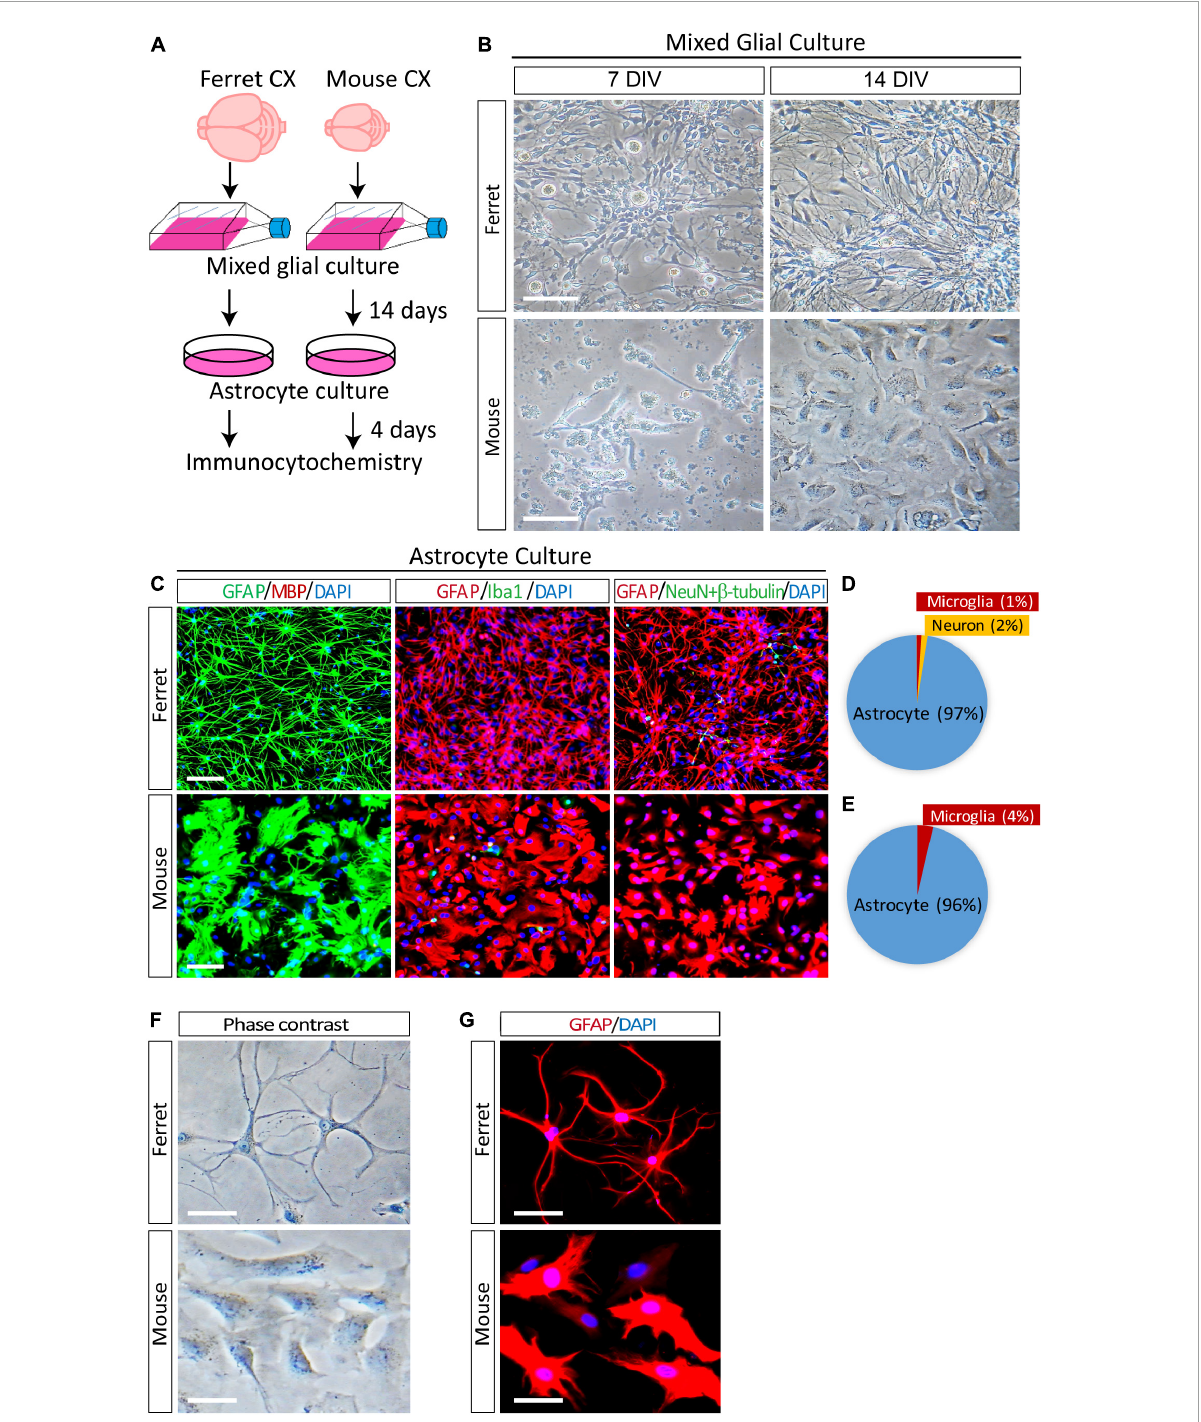
FIGURE1 Purification and morphological analysis of ferret and mouse astrocytes. (A) Experimental procedure used to culture ferret and mouse astrocytes. Mixed glial cells and astrocytes were cultured in media containing 10% fetal bovine serum. (B) Representative phase-contrast images of ferret and mouse mixed glial culture at 7 and 14 days in vitro (DIV). Scale bars = 100 µ m. (C) Cultured ferret and mouse astrocytes were subjected to immunocytochemistry of GFAP, MBP, Iba1, NeuN, and β -III tubulin at 4 days after plating. Nuclei were counterstained with DAPI. Scale bars = 100 µ m. (D,E) Proportion of astrocytes, oligodendrocytes, microglia, and neurons in ferret and mouse astrocyte cultures. n = 3 independent cultures. (F,G) Representative images of phase-contrast and immunocytochemistry of ferret and mouse astrocytes at 4 days after plating, with GFAP antibody. Nuclei were counterstained with DAPI. Scale bars = 20 µ